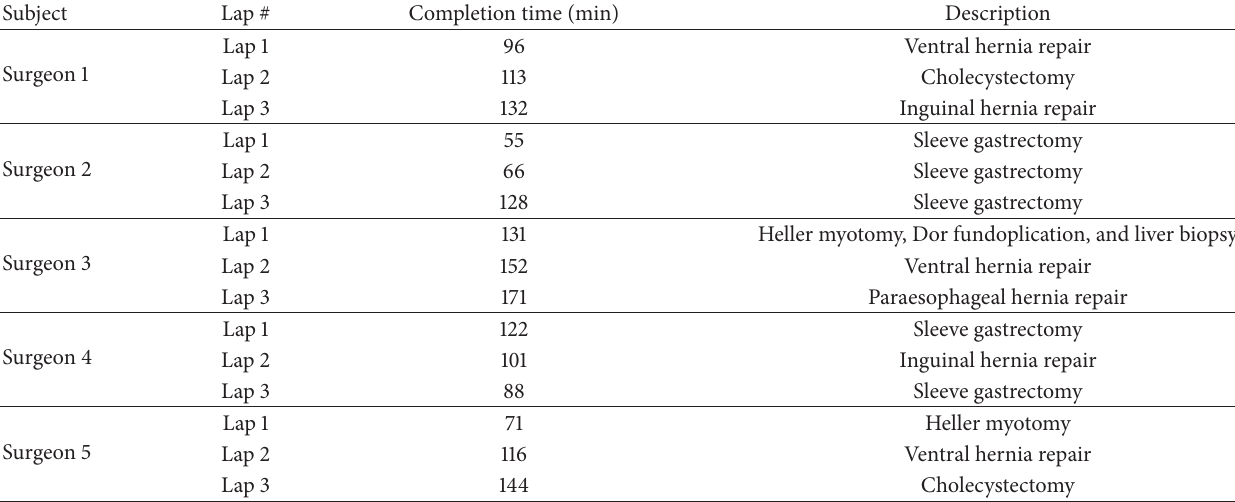
Table 1: MIS operations from which EMG data was collected ∗